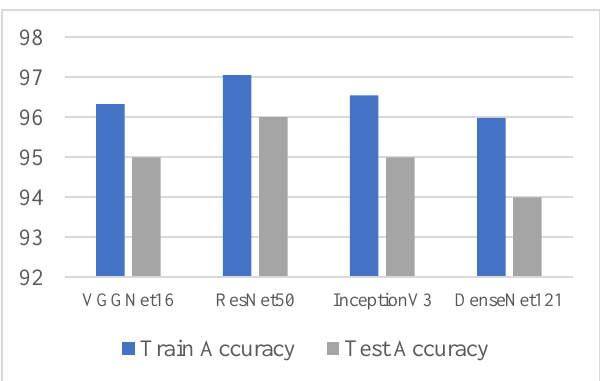
Fig. 12. Training and Testing accuracy of the evaluated